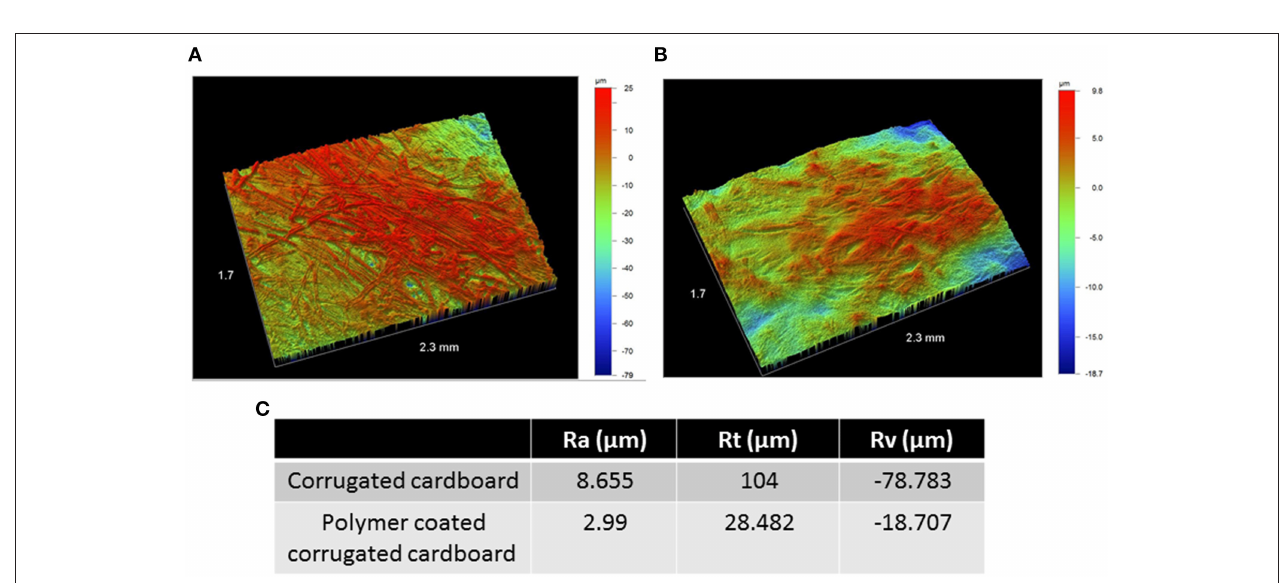
FIGURE 2 | Surface topography of bare corrugated cardboard surfaces (A) and polymer coated surfaces (B). Color scale to right of pictures denotes height and depth in microns. Columns in table: Profile roughness parameter (Ra), the maximum height (Rt), and maximum valley depth (Rv) of uncoated corrugated cardboard surfaces (row 1) and coated (300 µ m) surfaces (row 2) (C) . Both pictures and table indicate tempering of roughness profile with the addition of polymer on